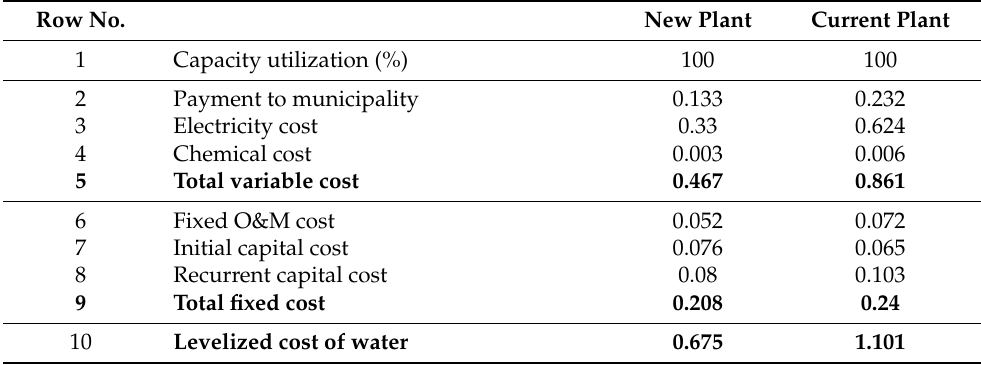
Table 8. Levelized financial costs of the water produced when operating at the full capacity of the two plants in 2022 prices, USD/m 3 . Row